Question: Does the figure show an increasing or a decreasing trend?
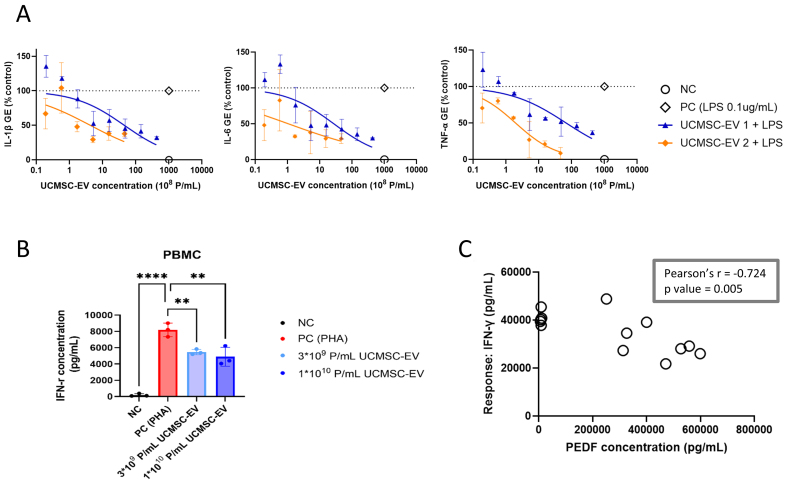
Answer: increasing